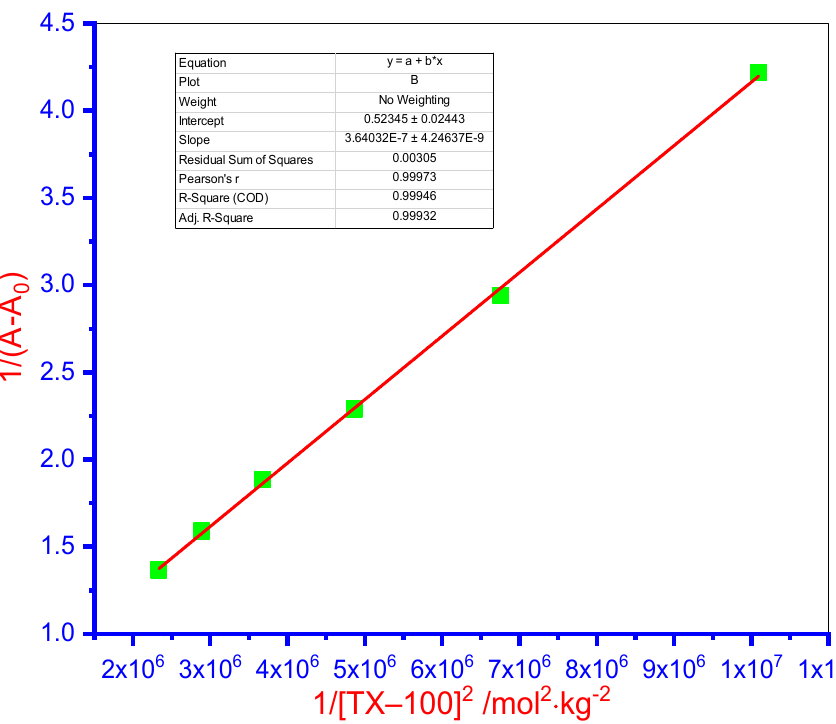
Figure 5. The plot of 1/(A − A 0 ) against 1/[TX-100] 2 for the interaction of the IMP drug with